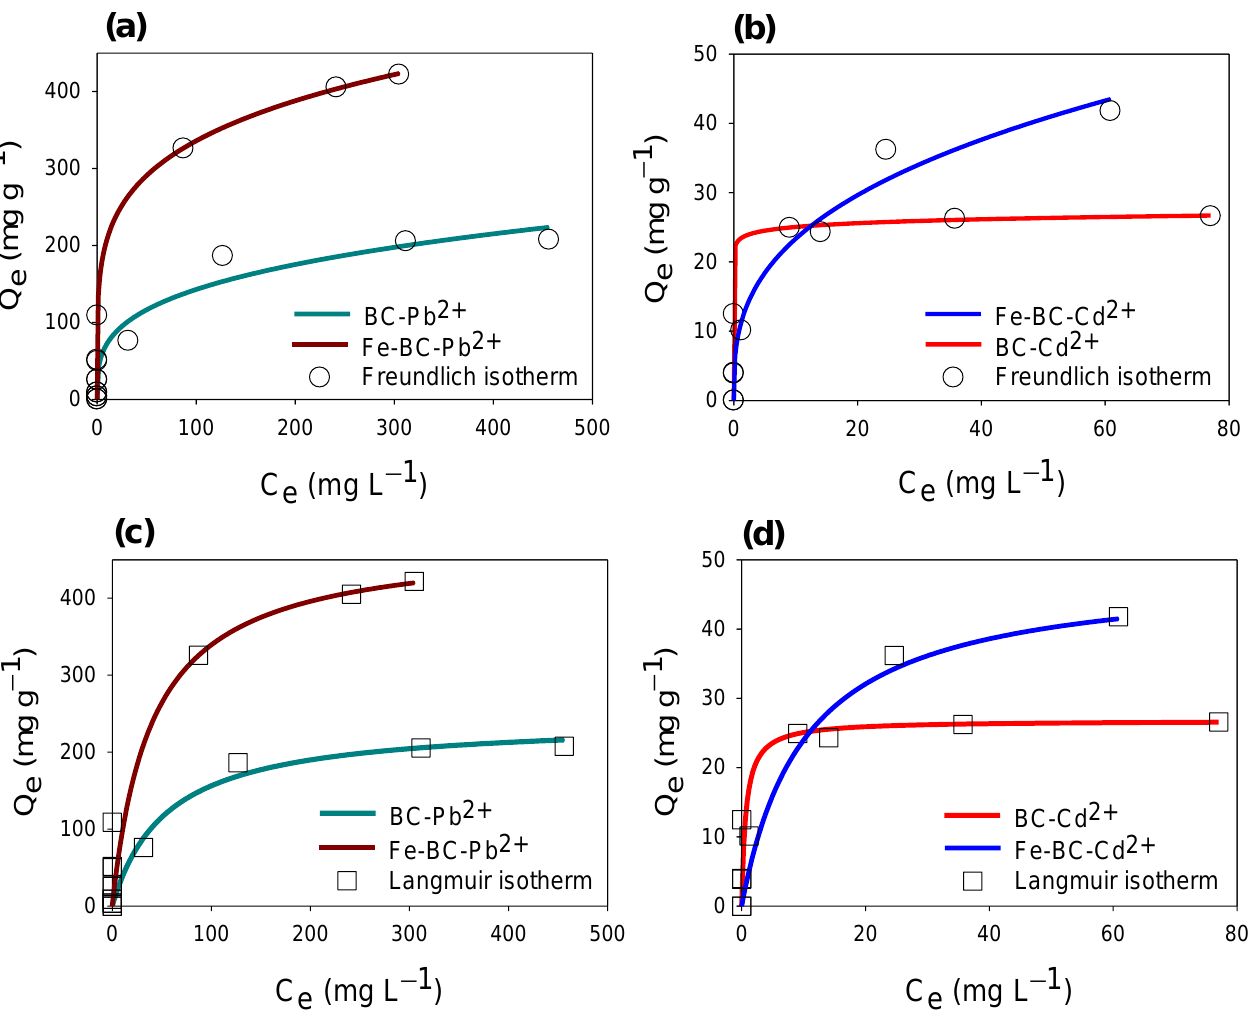
Figure 4. Isotherm curves for Freundlich ( a , b ) and Langmuir ( c , d ) models’ fittings for cadmium (Cd 2+ ) and lead (Pb 2+ ) adsorption on date palm waste biochar (BC) and Fe-modified biochar (Fe-BC). The parameters presented by the isotherm curve fittings are presented in Table 4. Both of the applied models fit best with the Pb 2+ adsorption, whereas Cd 2+ adsorption data